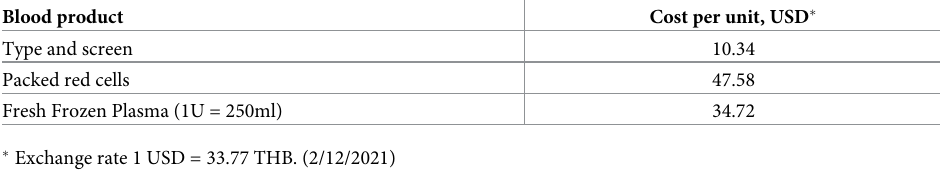
Table 2. Cost of blood product preparation per